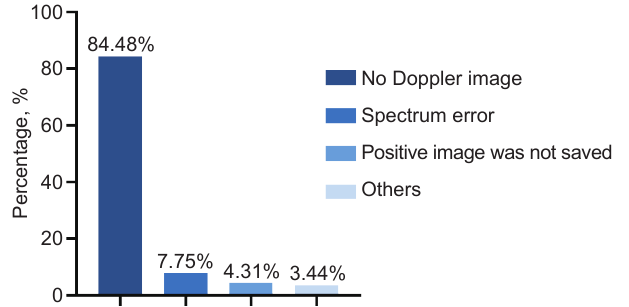
Figure 1 The total scores of the images and text reports from 2014 to 2018.